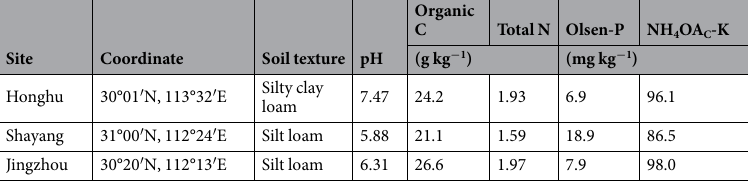
Table 4. Locations and soil properties in plow layer (0–20 cm) of three on-farm experimental sites in Hubei province of